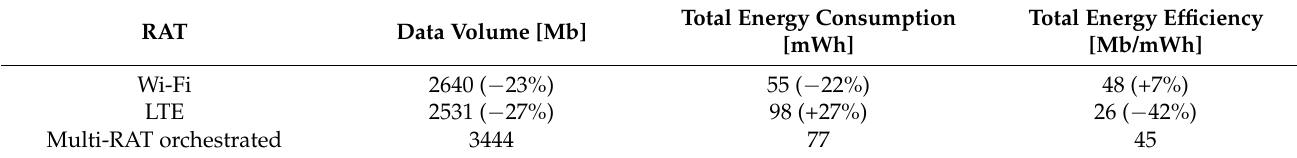
Table 4. Summary of aggregated KPIs for two different scenarios with indication of relative gains for Scenario A. RAT